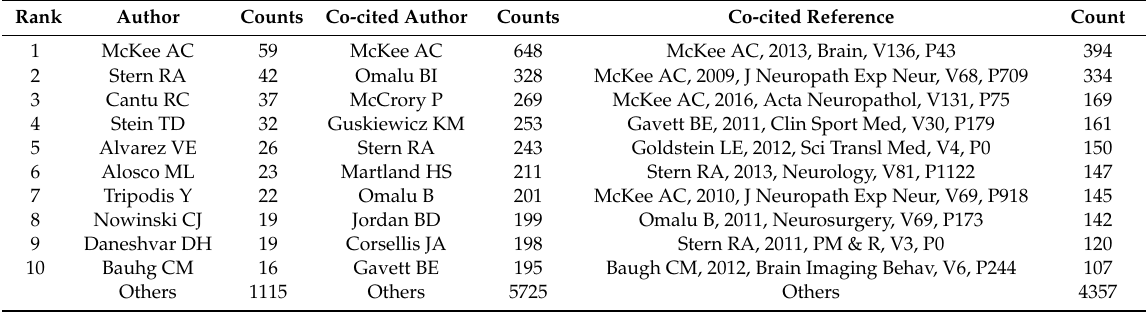
Table 3. Ranking of top 10 authors, co-cited authors, and co-cited references in the field of CTE from 1999 to 2019.